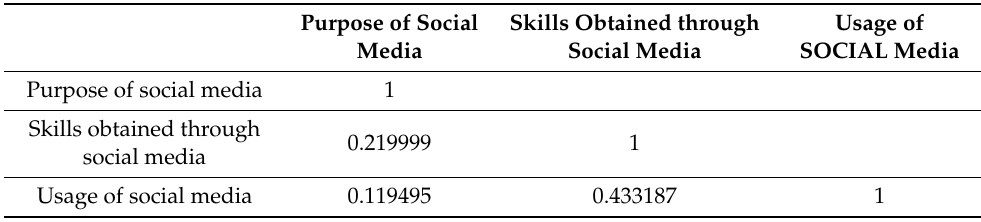
Table 5. Discriminant validity results.